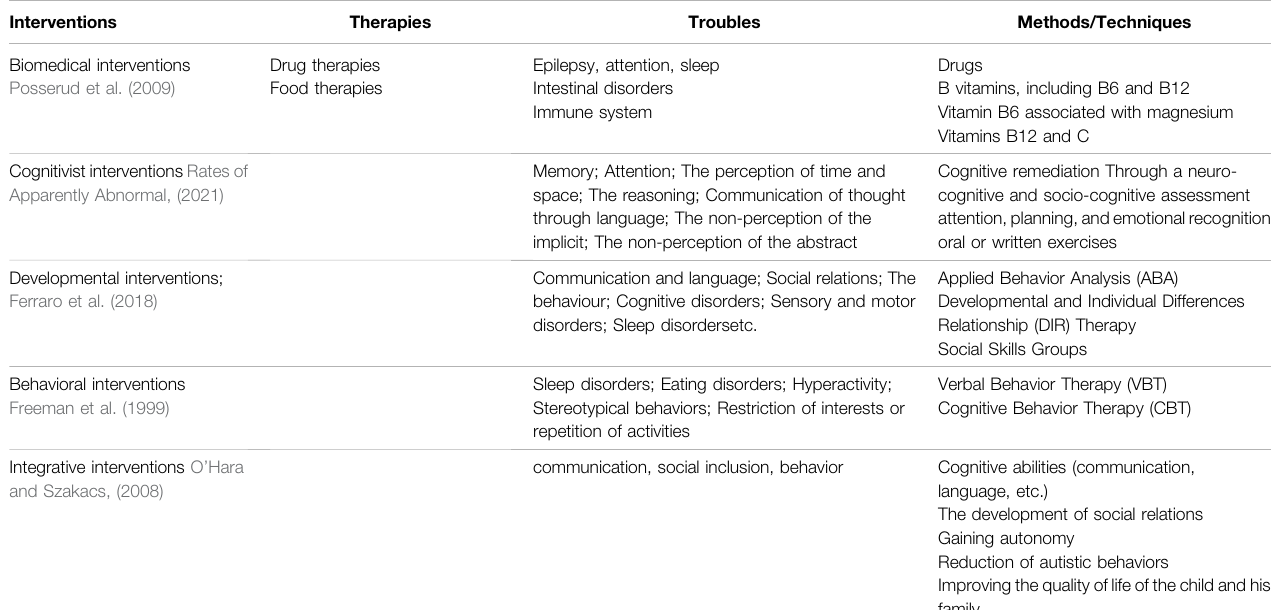
TABLE 2 | Interventions Used for ASD based on troubles